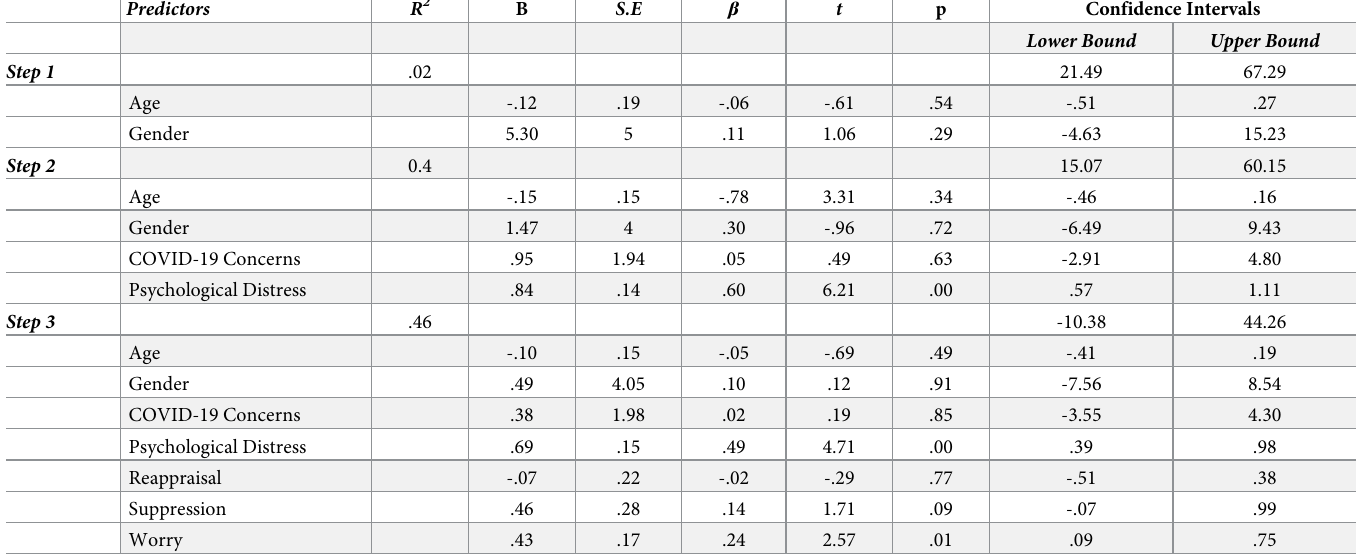
Table 2. Predictors of burnout: Hierarchical